Question: Briefly state, in one sentence, what is plotted here.
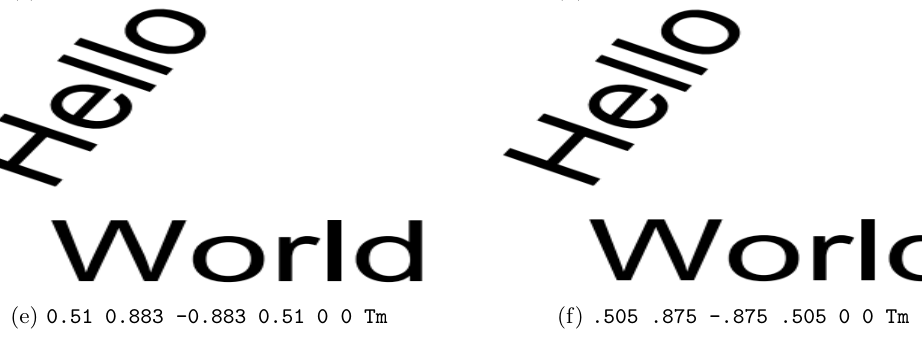
Answer: Tm Operator - control, 20%, 10%, 5%, 2%, 1% (5-10%)